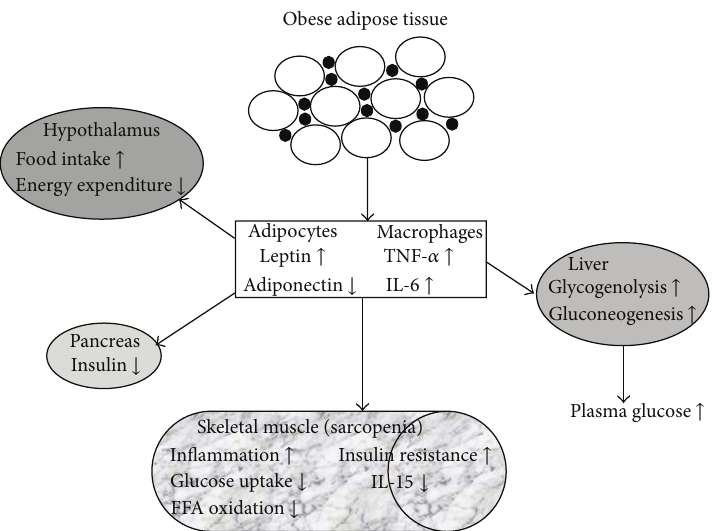
Figure 1: Obesity-induced changes in adipokine secretion and the development of insulin resistance in sarcopenic muscle. Expansion of adipose tissue in obesity leads to increased macrophage infiltration and inflammation with enhanced production of proinflammatory cytokines such as TNF- 𝛼 and IL-6. This is accompanied by a dysregulated secretion of leptin and adiponectin. These adipocyte- and macrophage-derivedadipokineselicitavarietyofadverseeffectsonnumeroustissuesincludingthehypothalamus,liver,pancreas,andskeletal muscle. On the systemic level, altered adipokine secretion can lead to increased food intake and reduced energy expenditure through actions in the hypothalamus and to decreased muscle insulin